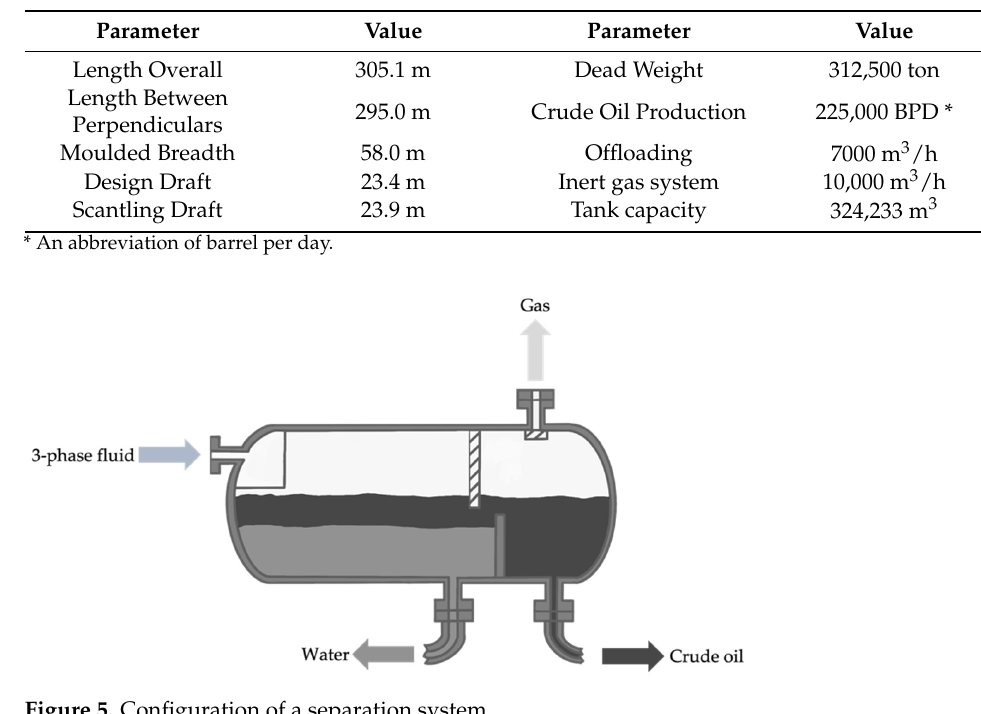
Figure 4. Configuration of a novel blanket gas system (Case C).